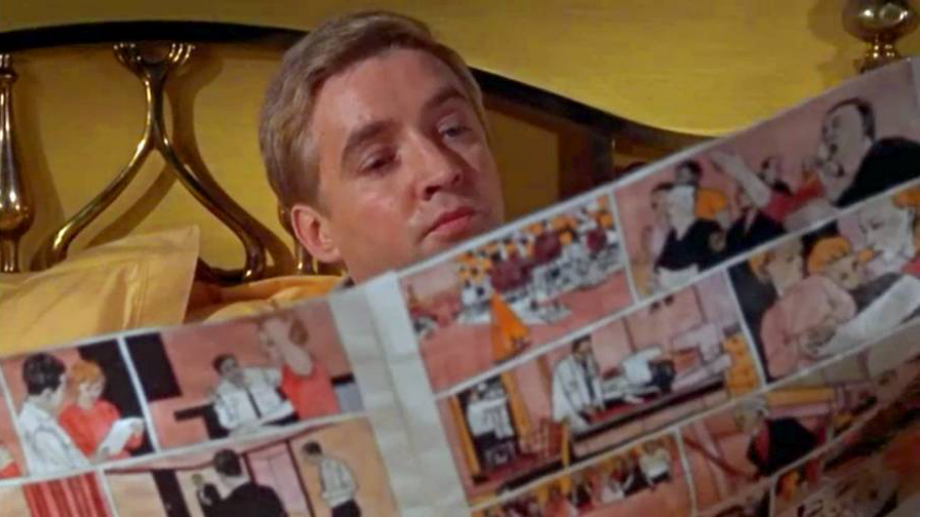
Figure 3. The newspaper in Fahrenheit 451 communicates through pictures alone [2].